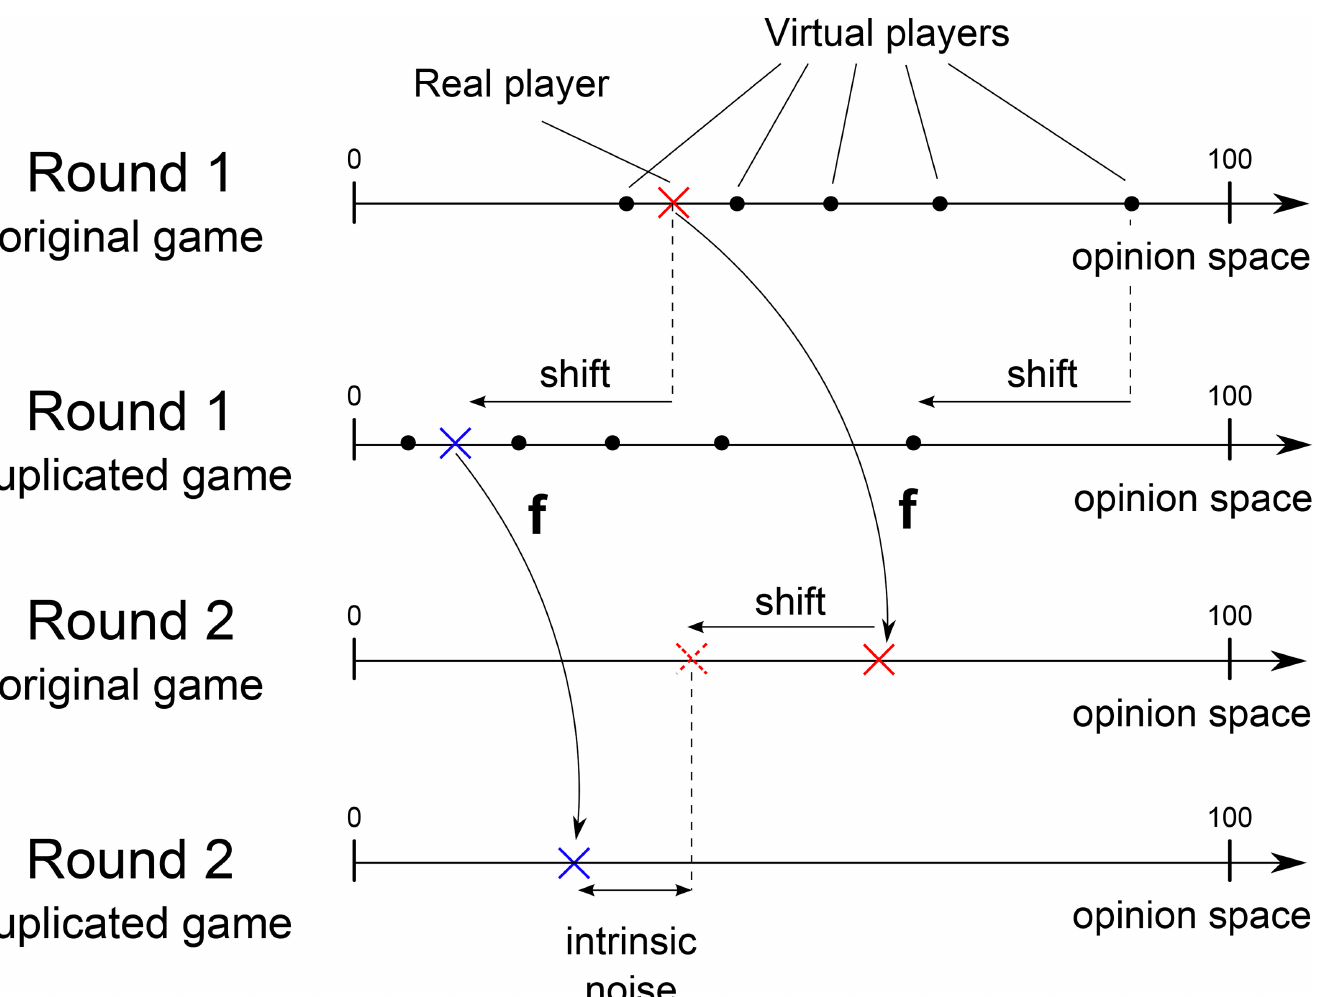
Fig 6. Illustration of the shift applied to the synthetic judgment in order to preserve the distances between initial judgments. The shift made by the participant in the first round was synthetically applied to all other initial judgments. The intrinsic variation in judgment revision is the distance between second round judgments, reduced by the shift in initial judgments. The dotted cross is not a judgment and is only displayed to show how the second round intrinsic variation is computed using the initial shift. All shifts are equal. The same shift is also applied to all other second round judgments, and used to compute final round intrinsic